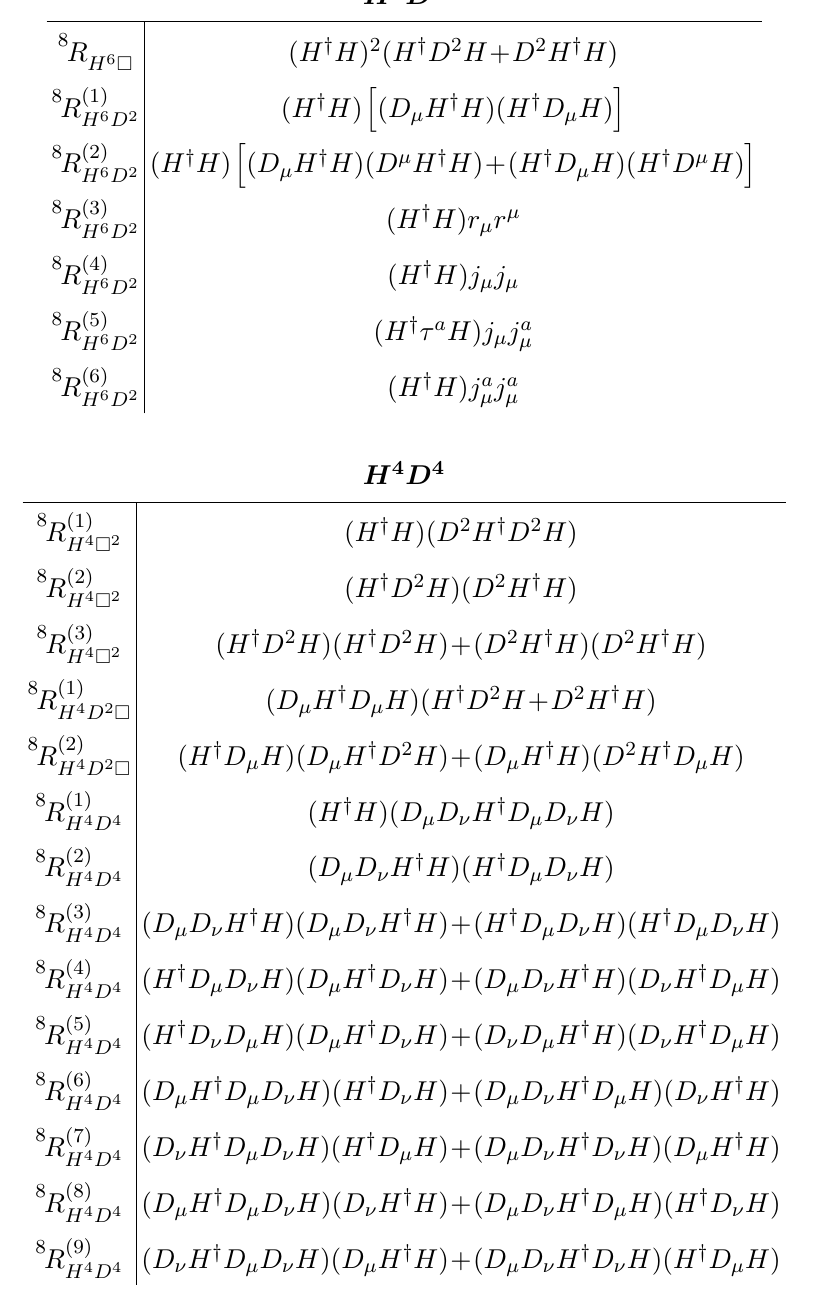
Table 6 . Redundant even-parity bosonic dimension-eight operators in the SMEFT, part